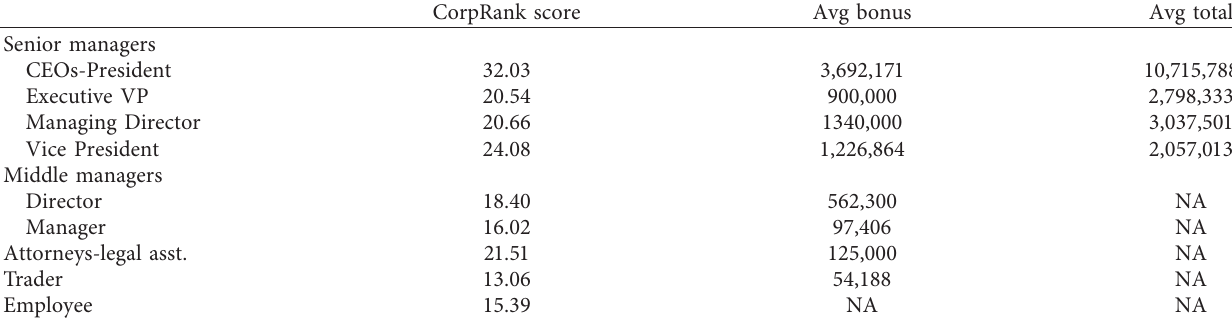
Table 7: Compensation and average CorpRank score by hierarchical categories for Enron’s employees. Average bonus includes regular performance bonus and a retention bonus given to a selected group of employees in 2001 according to [59]. Avg total is the average total direct compensation. Average bonus and average total direct compensation are in U.S. dollars. NA indicates that information is not available.